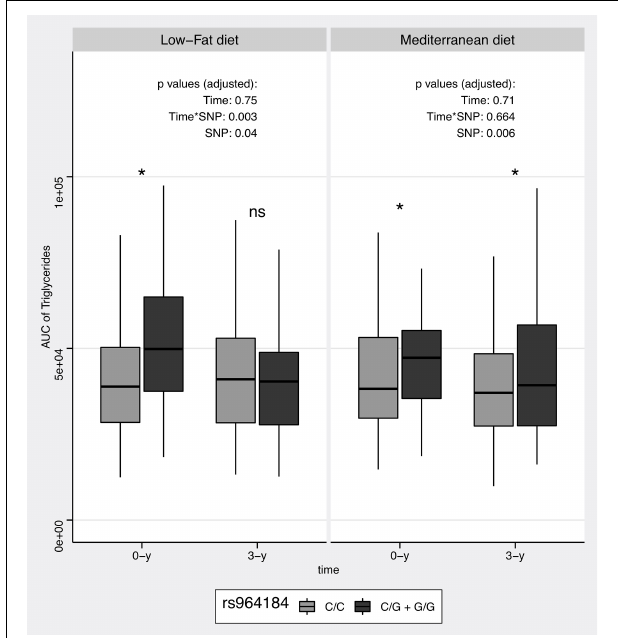
FIGURE 3 | Postprandial AUC of triglycerides according to intervention diet and rs964184 genotypes. Values are shown as box plots, with the median, the approximate quartiles, and the lowest and highest data points. P -values were adjusted for age, gender, lipid-lowering drugs, and body mass index. *, p -value between genotypes < 0.05; ns, p -value between genotypes >